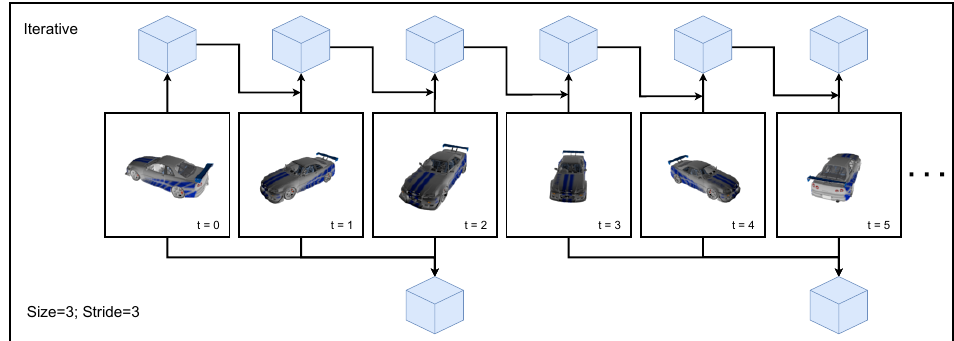
Figure 7. This figure gives an example of a batch processing method versus iterative processing. The iterative method is able to deliver a newly updated reconstruction every iteration (number of reconstructions (NoR) = 6), whereas the batch method produces two reconstructions (NoR =